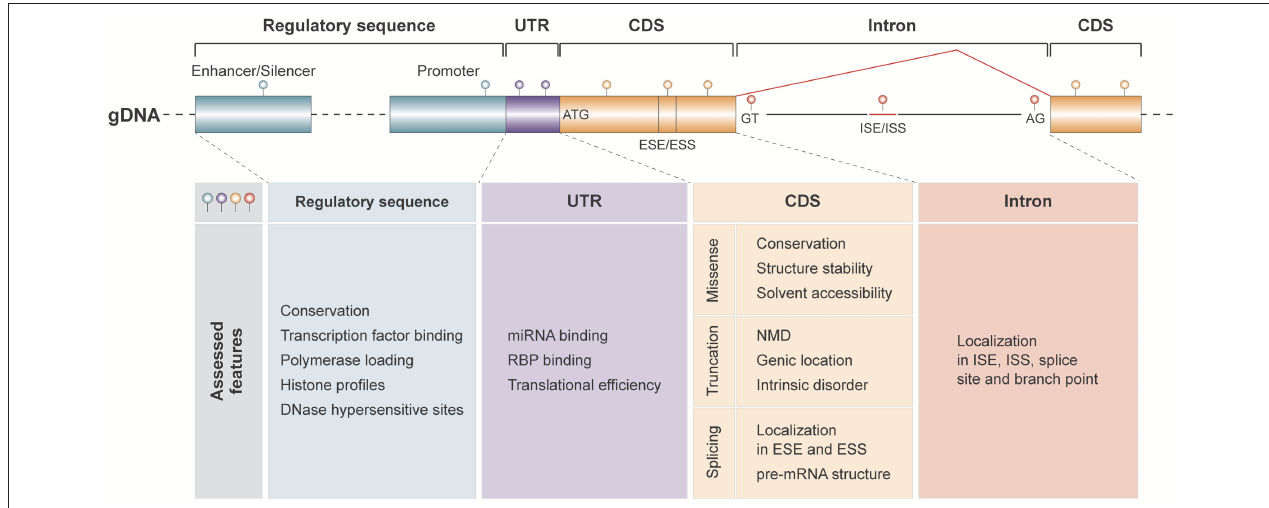
FIGURE 1 | Overview of features that can be assessed by current computational prediction methods. Different parameters and features are assessed for genetic variants depending on whether they are localized in putatively regulatory sequences, untranslated regions (UTR) of the gene, its coding sequences (CDS) or within introns. ESE/ESS, exonic splicing enhancer/silencer; ISE/ISS, intronic splicing enhancer/silencer; NMD, nonsense-mediated decay; RBP, RNA binding